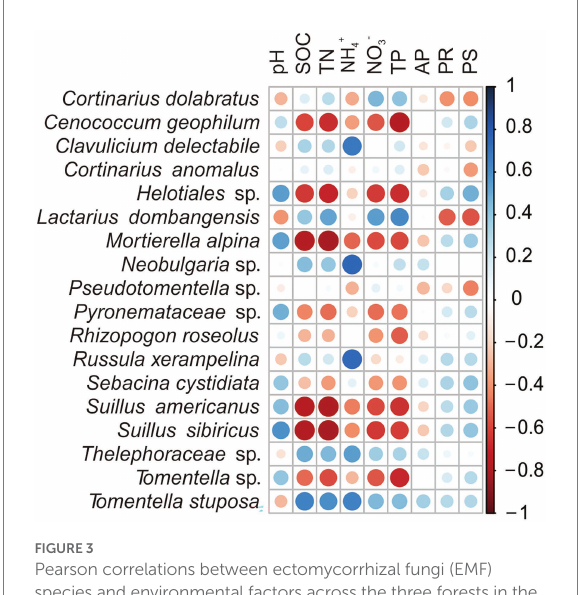
FIGURE 3 Pearson correlations between ectomycorrhizal fungi (EMF) species and environmental factors across the three forests in the study area. Values indicate means ± standard errors (SE; n = 5).